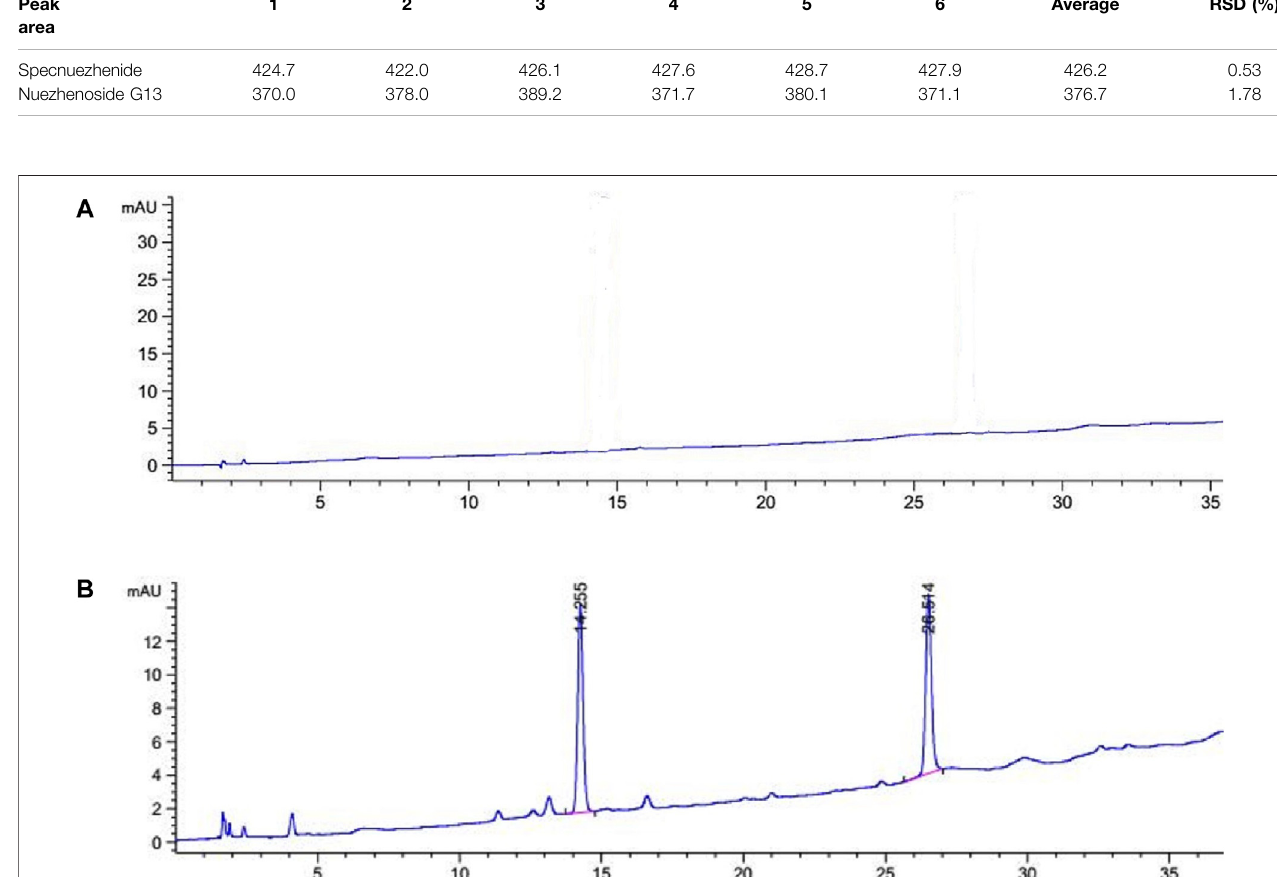
FIGURE 4 | The HPLC chromatograms of OFSN [ (A) blank chromatograms; (B) the OFSN chromatograms].